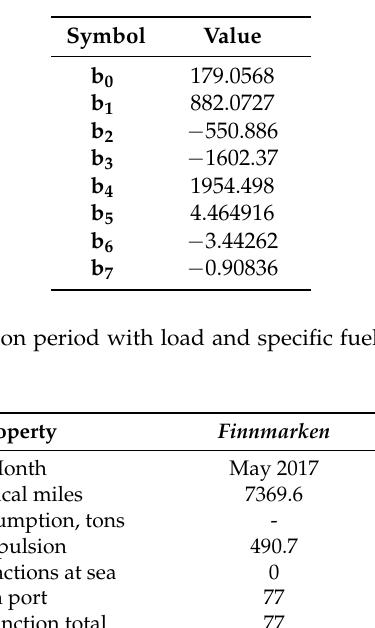
Table 12. Coefficients for estimating specific fuel consumption from Finnmarken data.